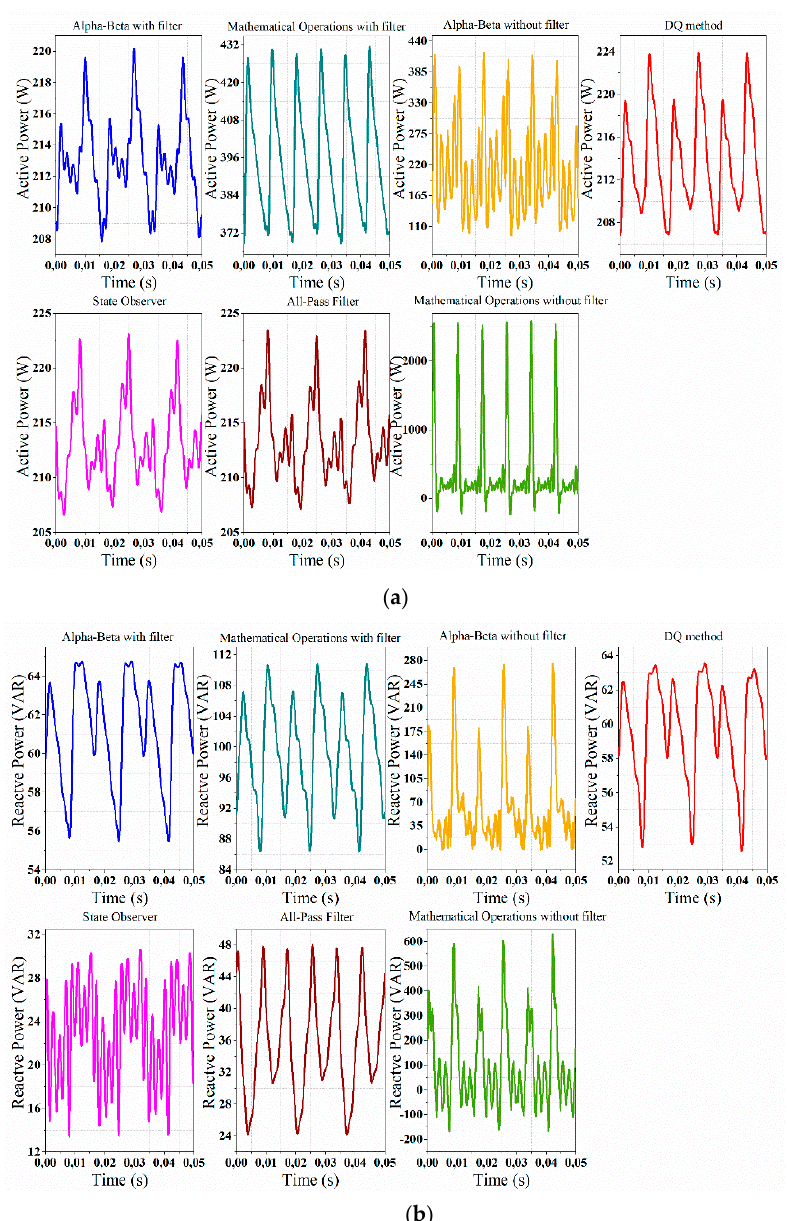
Figure 14. Power calculation at fundamental frequency + 3rd harmonic + 5th harmonic + 7th harmonic: ( a ) active power; ( b ) reactive power.